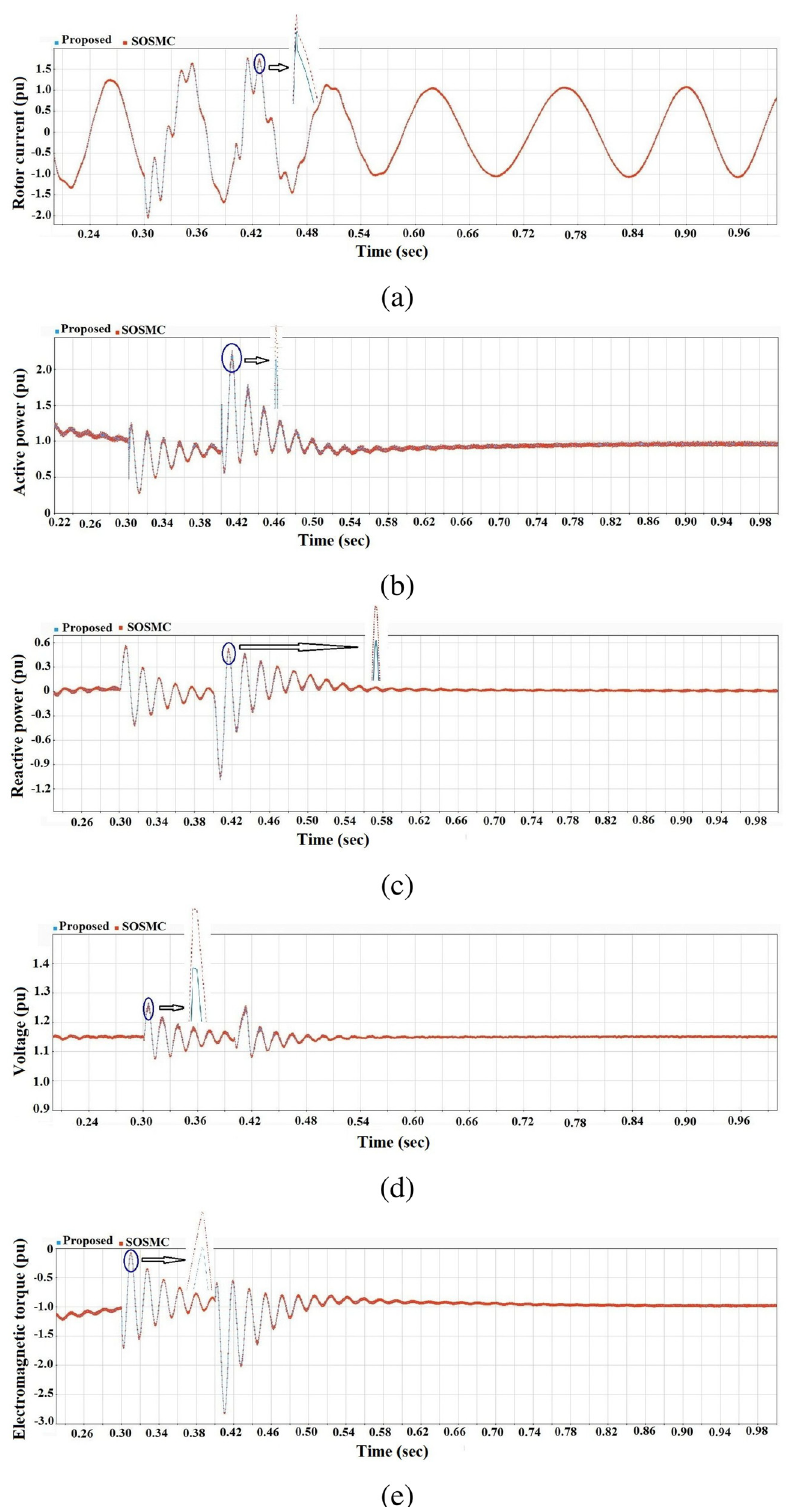
Figure 14: Comparison of SOSM and proposed controller during LVRT capability of DFIG system during grid fault: ( a ) rotor current, ( b ) real power, ( c ) reactive power, ( d ) DC - link voltage, and ( e ) electromagnetic